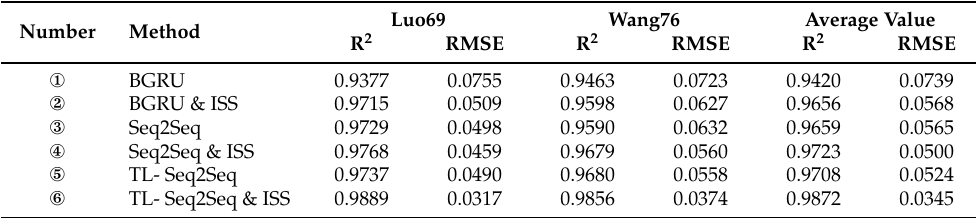
Table 5. Ablation experimental results with different